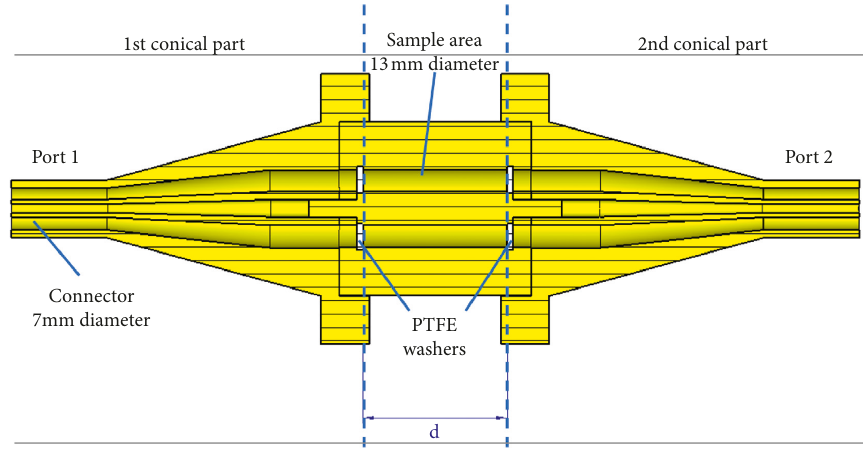
Figure 1: Measurement coaxial line. CST design.